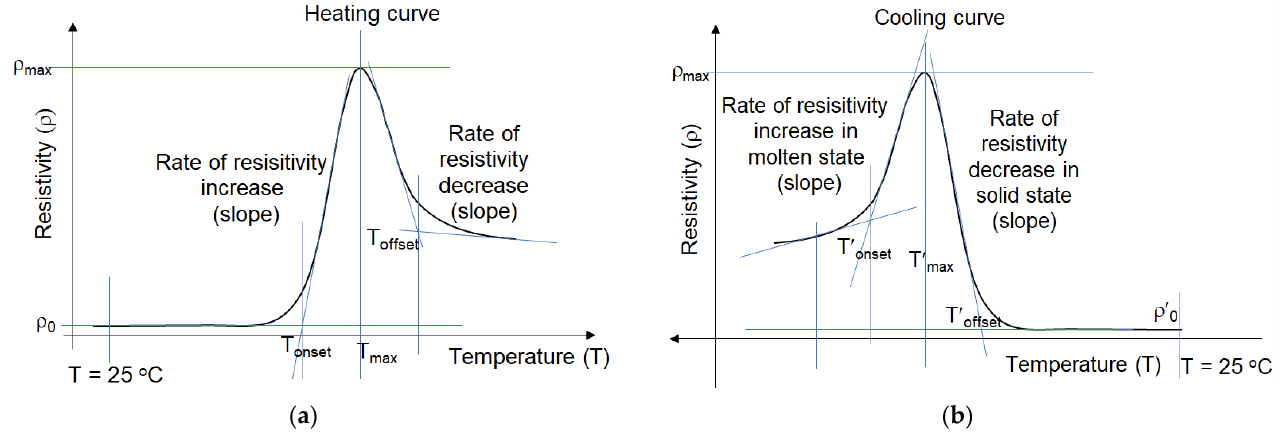
Figure 3. Typical  -T heating ( a ) and  -T cooling ( b ) curves and parameters used for kinetic charac- terization of resistivity vs. temperature. terization of resistivity vs.